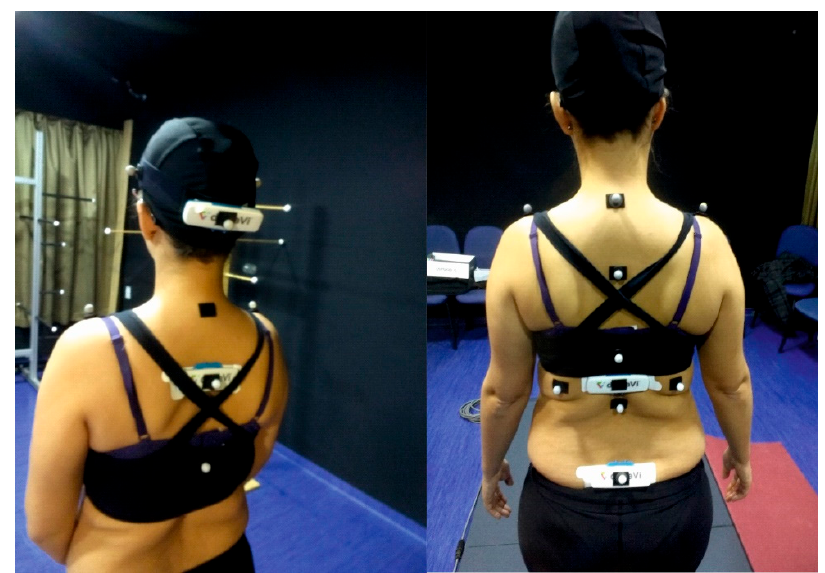
Figure 2. UCOTrack marker set and ViMove sensor location for analyzing cervical and lumbar spinal mobility.